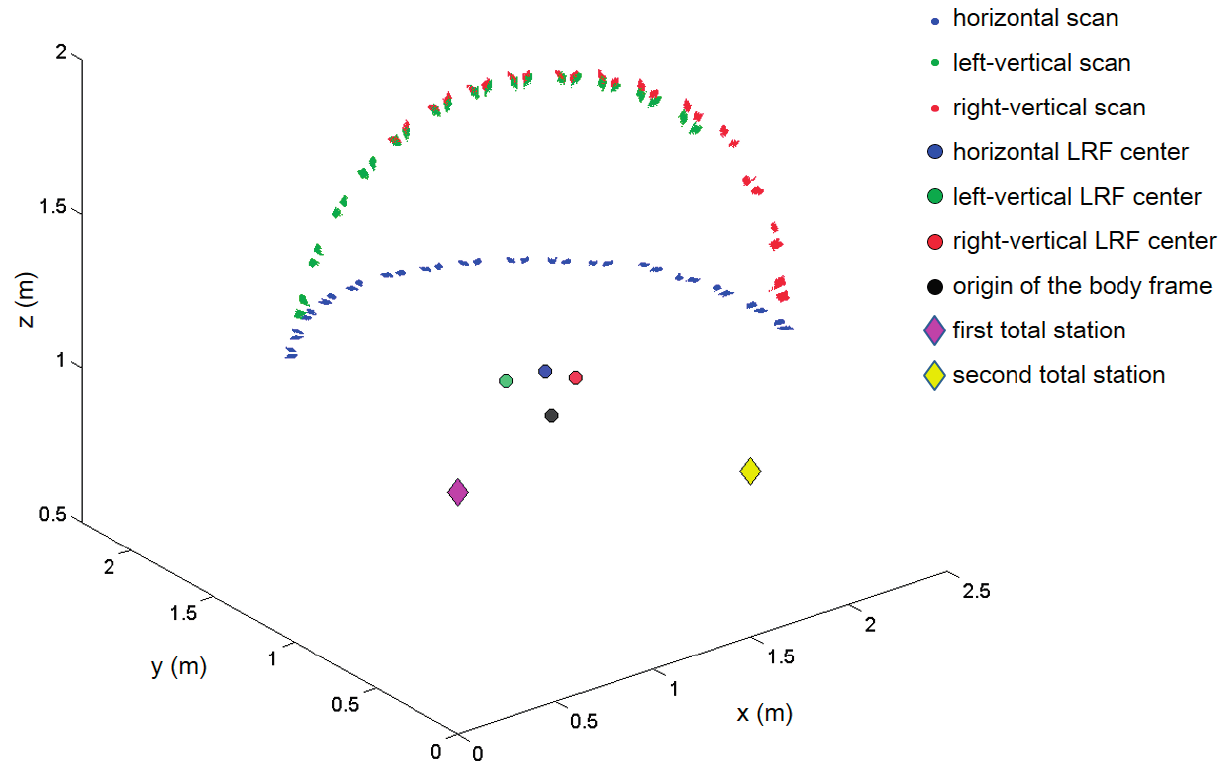
Figure 13. Point-cloud data acquisitions by the developed scanning